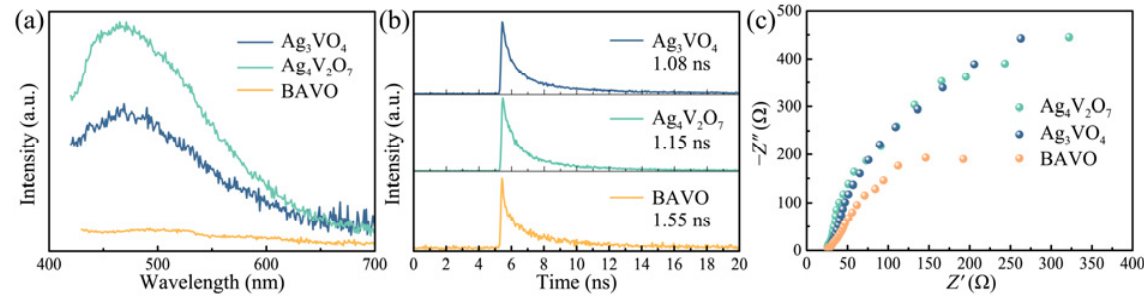
Fig. 7 (a) PL spectra, (b) fluorescence emission decay curves, and (c) EIS Nyquist plots for Ag 3 VO 4 , Ag 4 V 2 O 7 , and BAVO